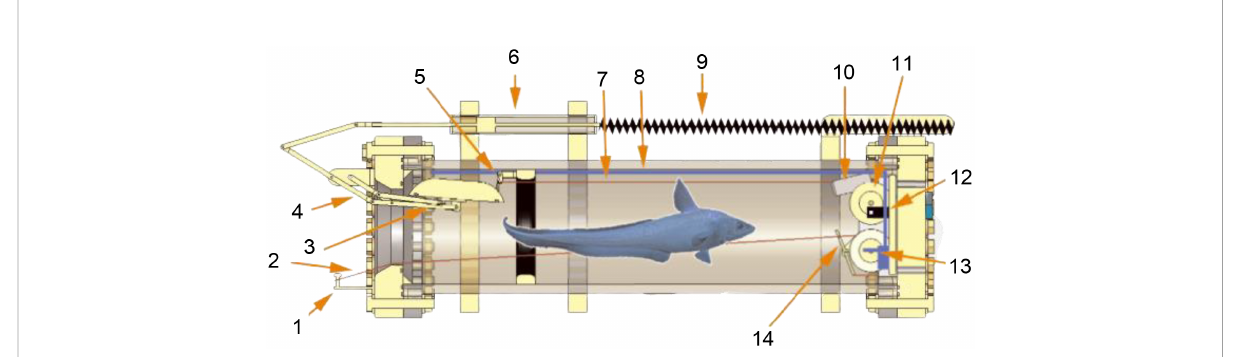
FIGURE 8 Schematic diagram of hyperbaric trap respirometer (1: Pin to hold the release shackle/hook assembly; 2: Retraction line connected to hook; 3: Door; 4: Door linkage system; 5: Door latch; 6: Hydraulic dampening piston; 7: Line to door release plate; 8: Tubing to draw water to pump; 9: Extension springs; 10: Camera with integrated LED lighting; 11: Wheels for coiled constant force springs; 12: Oxygen probe; 13: Water circulation pump; 14: Release trigger for door.)(adapted from Drazen et al., 2005).